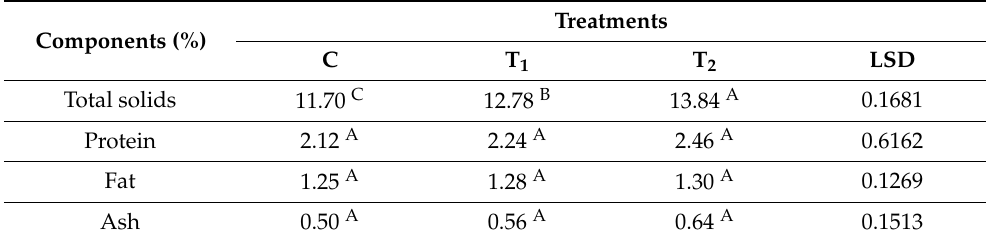
Table 2. Chemical composition of a yogurt drink fortified with golden berry juice on the first day of storage.